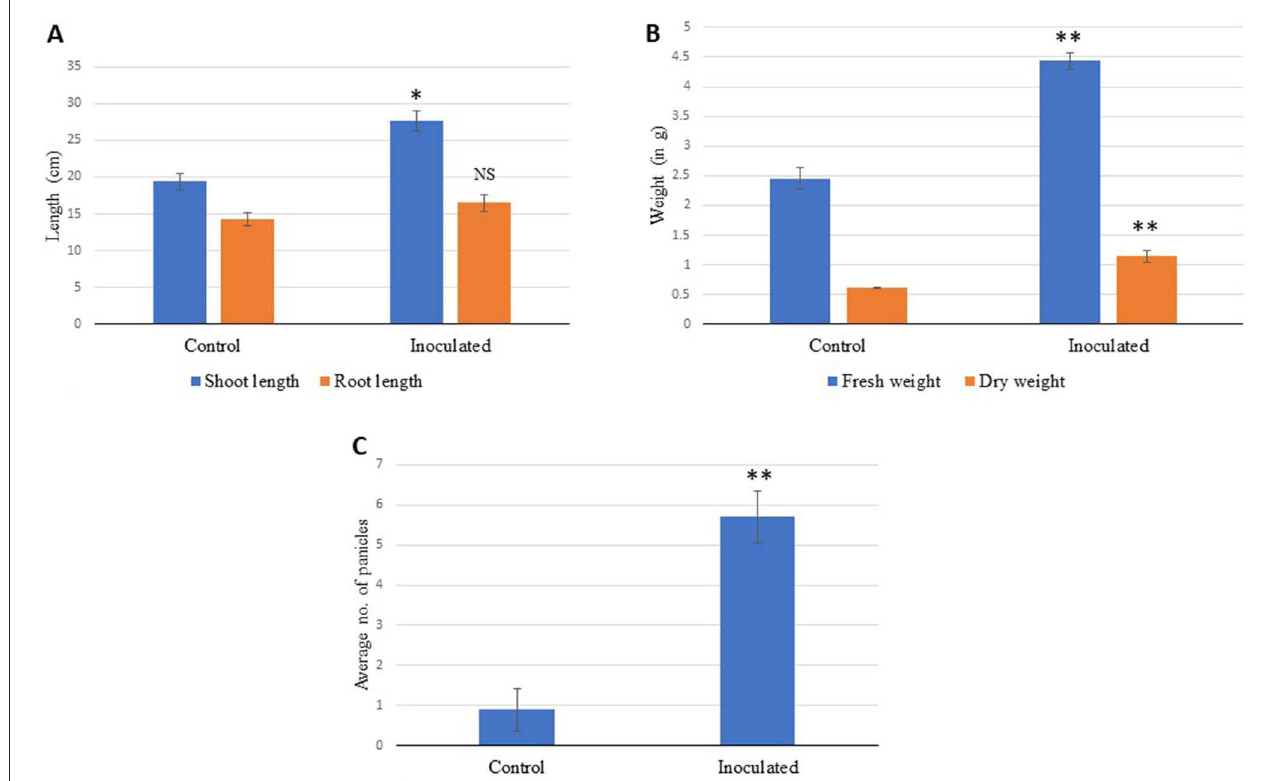
FIGURE5 (A) Effect of bioinoculant on the shoot and root lengths, (B) shoot fresh and dry weights, and (C) number of panicles in A. paniculata grown for 70 days in pots under the controlled conditions compared to control. The data showing significance are marked with NS, not significant; *very statistically significant; **extremely statistically significant.